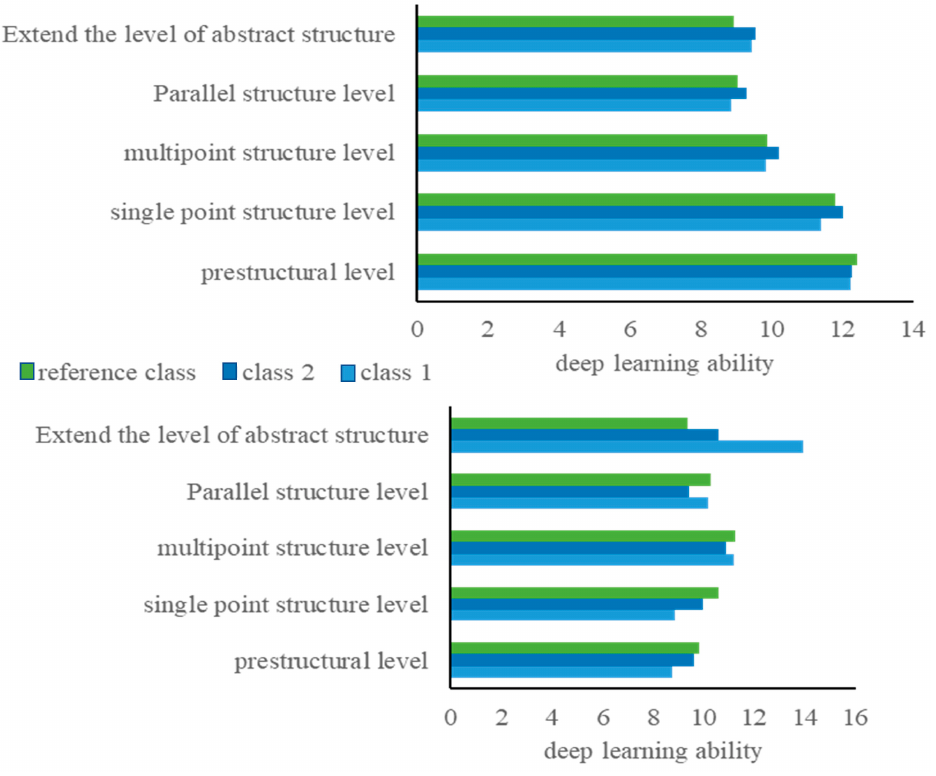
Figure 10. Comparison and analysis of the deep learning ability of students in the experimental class and the control class before and after the experiment.